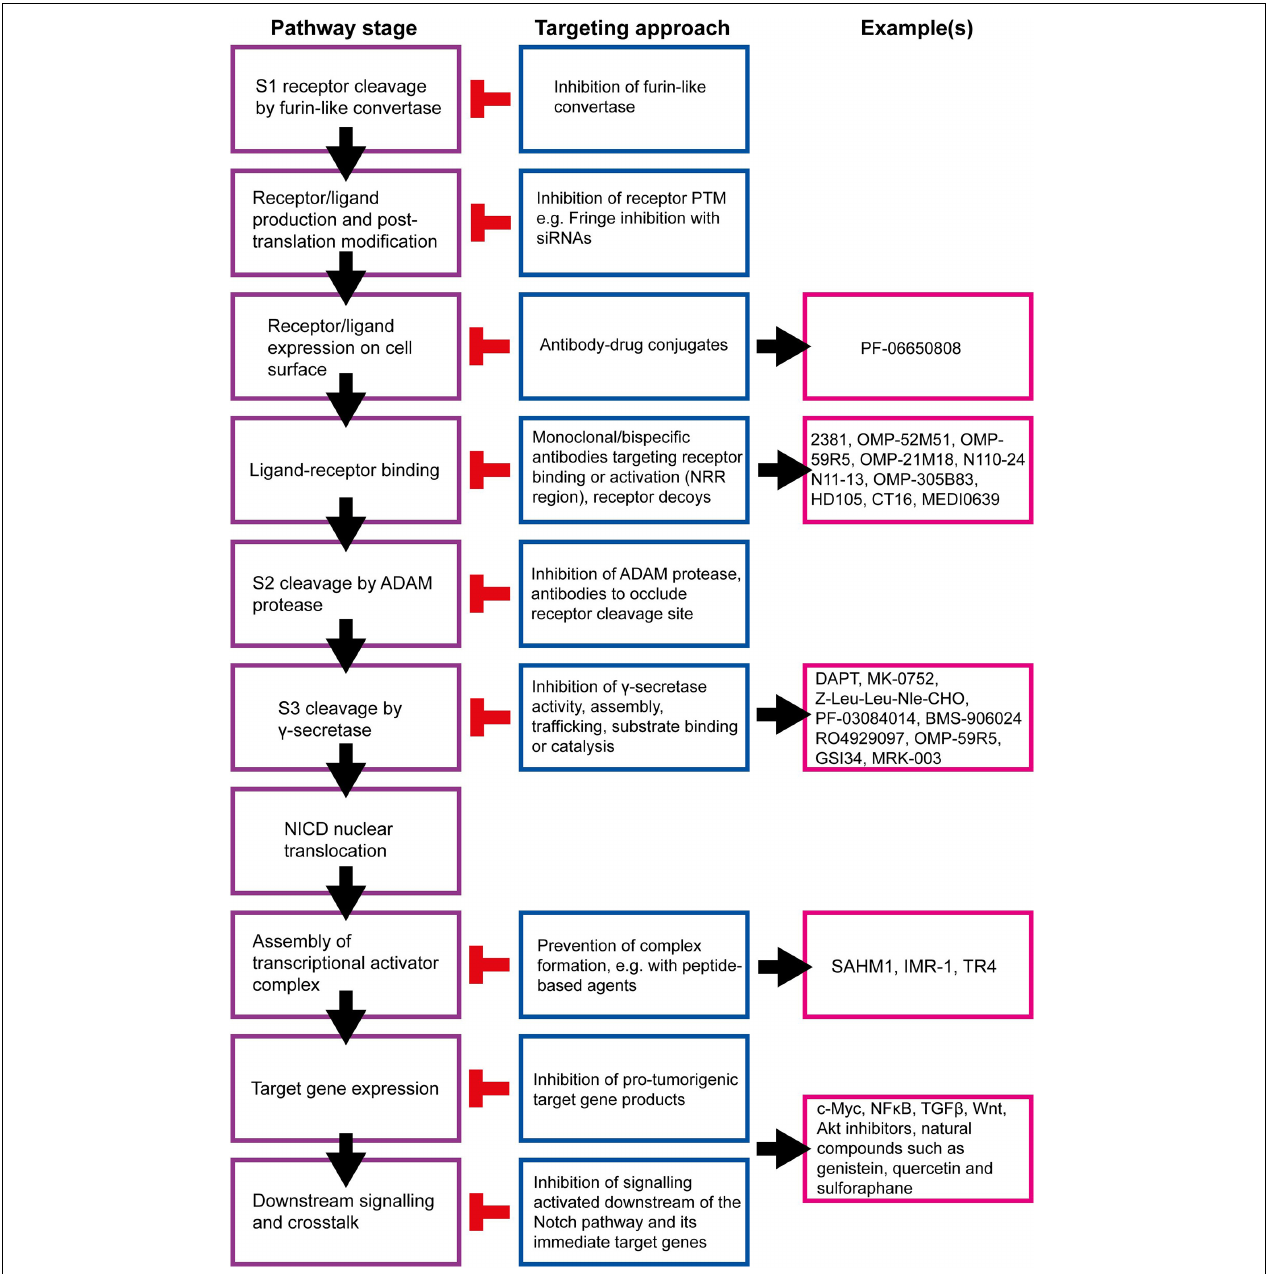
FIGURE 8 | Summary of targetable points of the Notch pathway. The Notch signalling pathway can be inhibited at almost all stages, and a number of strategies are being developed to target these steps for therapeutic purposes (Andersson and Lendahl, 2014). γ -secretase inhibitors (GSIs) are the most well-established Notch inhibitors. Most competitively inhibit presenilin in the γ -secretase complex, and are hence pan Notch inhibitors that prevent all signalling events downstream of the Notch receptor regardless of receptor isoform or activating ligand (Krishna et al., 2019). The γ -secretase complex can also be targeted with monoclonal antibodies raised against presenilin or nicastrin (Hayashi et al., 2012; Takagi-Niidome et al., 2013; Zhang et al., 2014). Other pan Notch inhibitors include those that target the NICD/RBPJ κ /MAML transcriptional activator complex. SAHM1 is a synthetic hydrocarbon-stapled α -helical peptide designed to mimic a portion of the N terminus